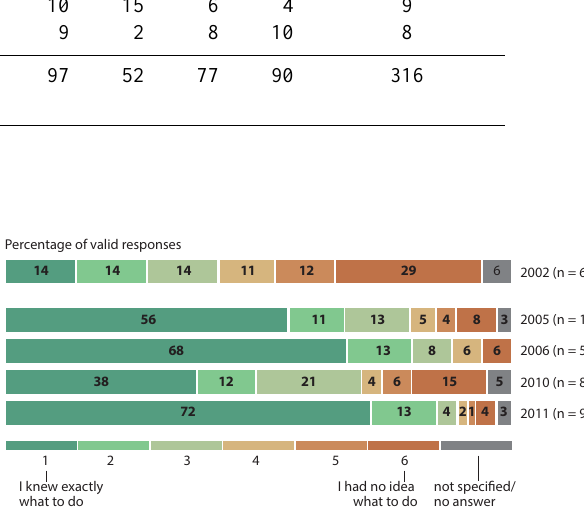
Figure 4. People’s knowledge about how to protect themselves and their households against the